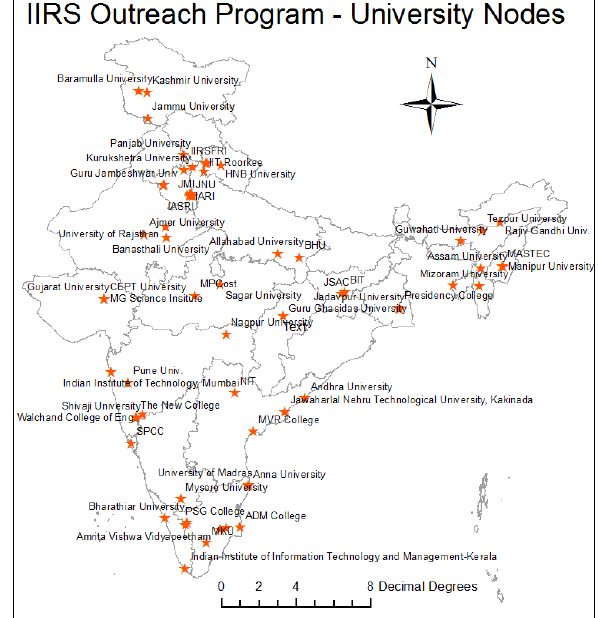
Figure 1: IIRS Network of outreach program